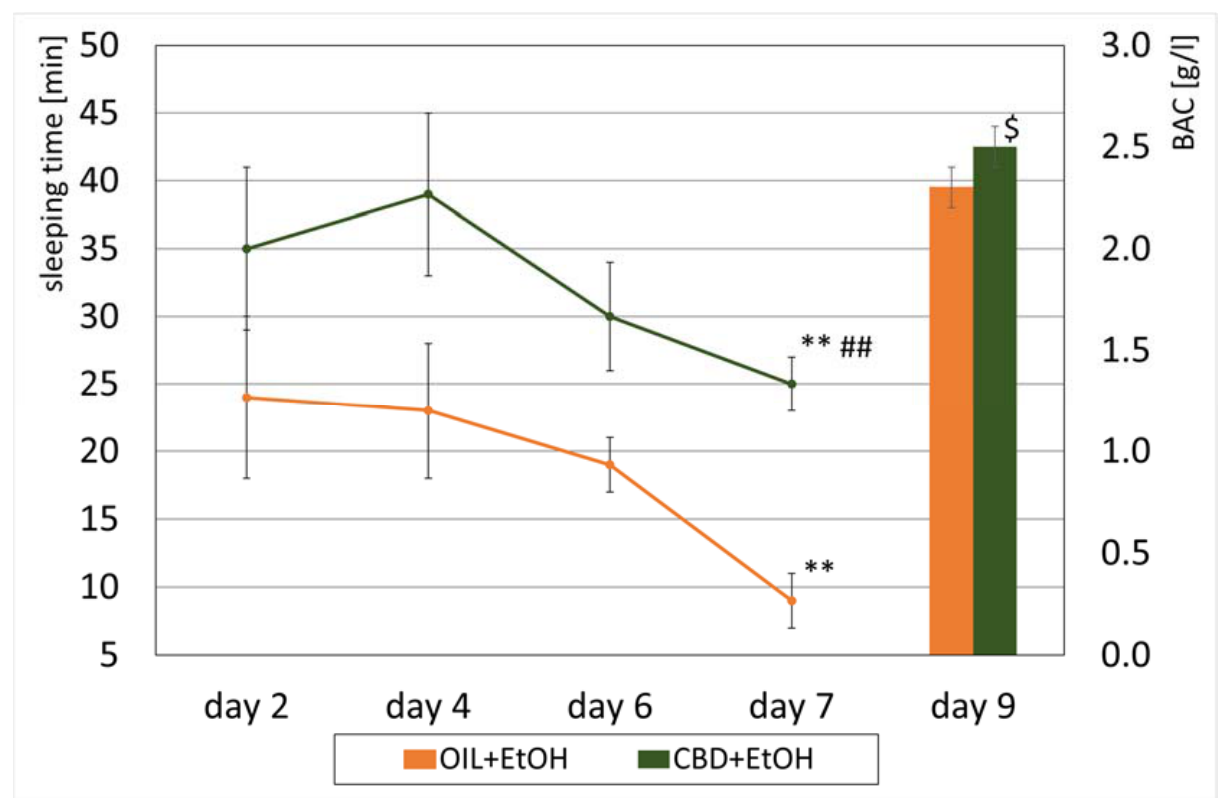
Figure 5. The effect of CBD (cannabidiol; 20 mg/kg, p.o.) or OIL (rapeseed oil) administration repeated once a day for 8 days on EtOH-induced (ethanol; 3.0 g/kg/day, i.p.) sleeping time on selected days (2, 4, 6, 7) and BAC (peripheral blood alcohol concentration) values on day 9. Mean ± SEM, n = 9. Legend: **—a statistically significant vs. day 2 and 4 for CBD + EtOH and vs. all previous days in group OIL + EtOH, p < 0.01; ##—a statistically significant vs. OIL + EtOH in day 7, p < 0.01; $—a statistically significant vs. OIL + EtOH group, p < 0.05 (BAC).